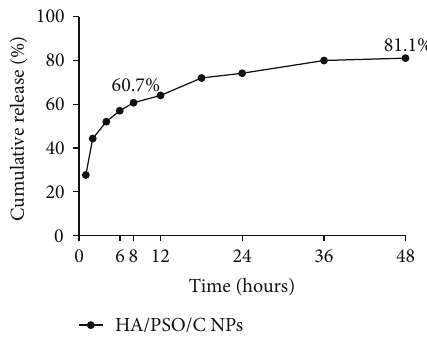
Figure 2: LC/MS analysis of PSO. Consistent with theoretical calculated molecular mass, molecular weight of puri fi ed PSO was about 715.33Da analyzed by Agilent 6210 time-of- fl ight LC/MS.